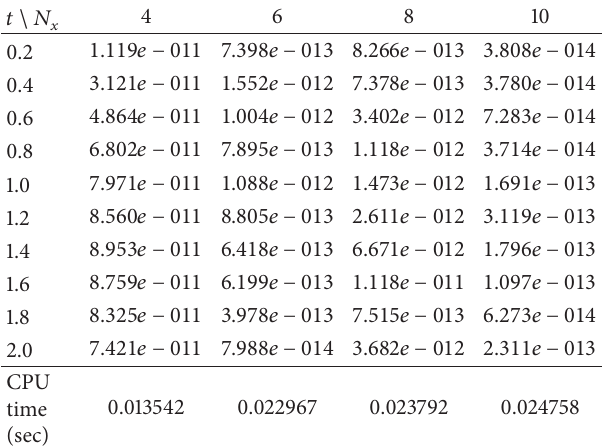
Table 9: Maximum errors 𝐸 𝑁 for the Fitzhugh-Nagumo equation when 𝛼 = 1 using 𝑁 𝑡 = 10 .